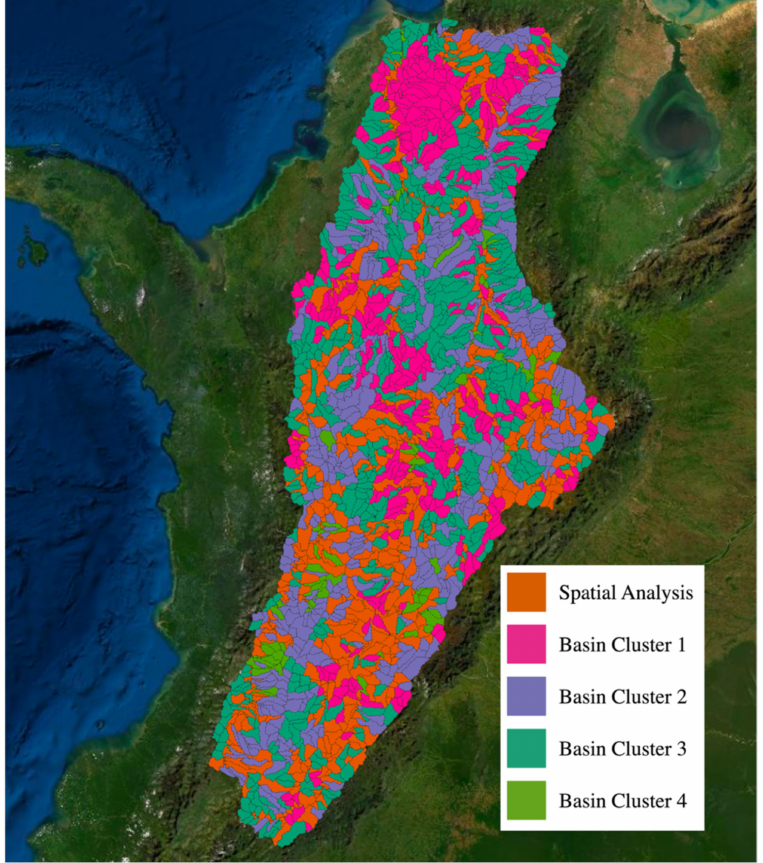
Figure 9. Map of subbasins for the GEOGloWS ECMWF Streamflow model’s stream segments colored in groups that share the same assignment justification.